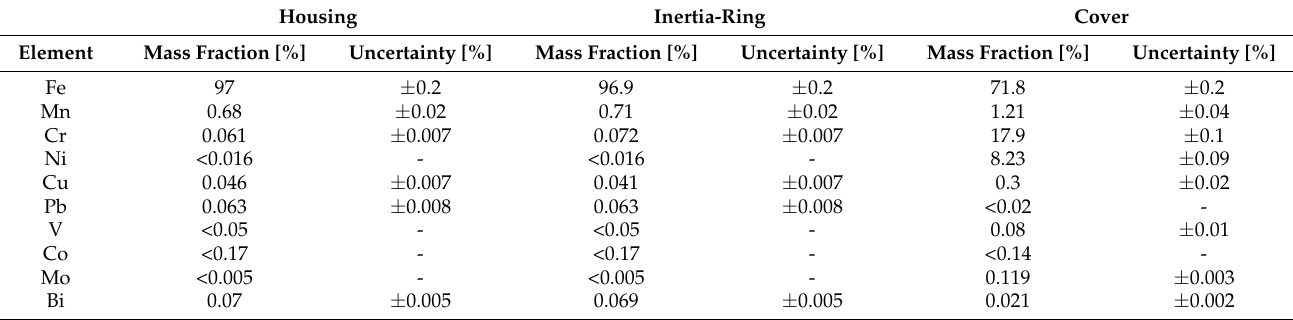
Table 1. Results of the X-ray fluorescence spectrometric analysis on a real visco-damper. Housing